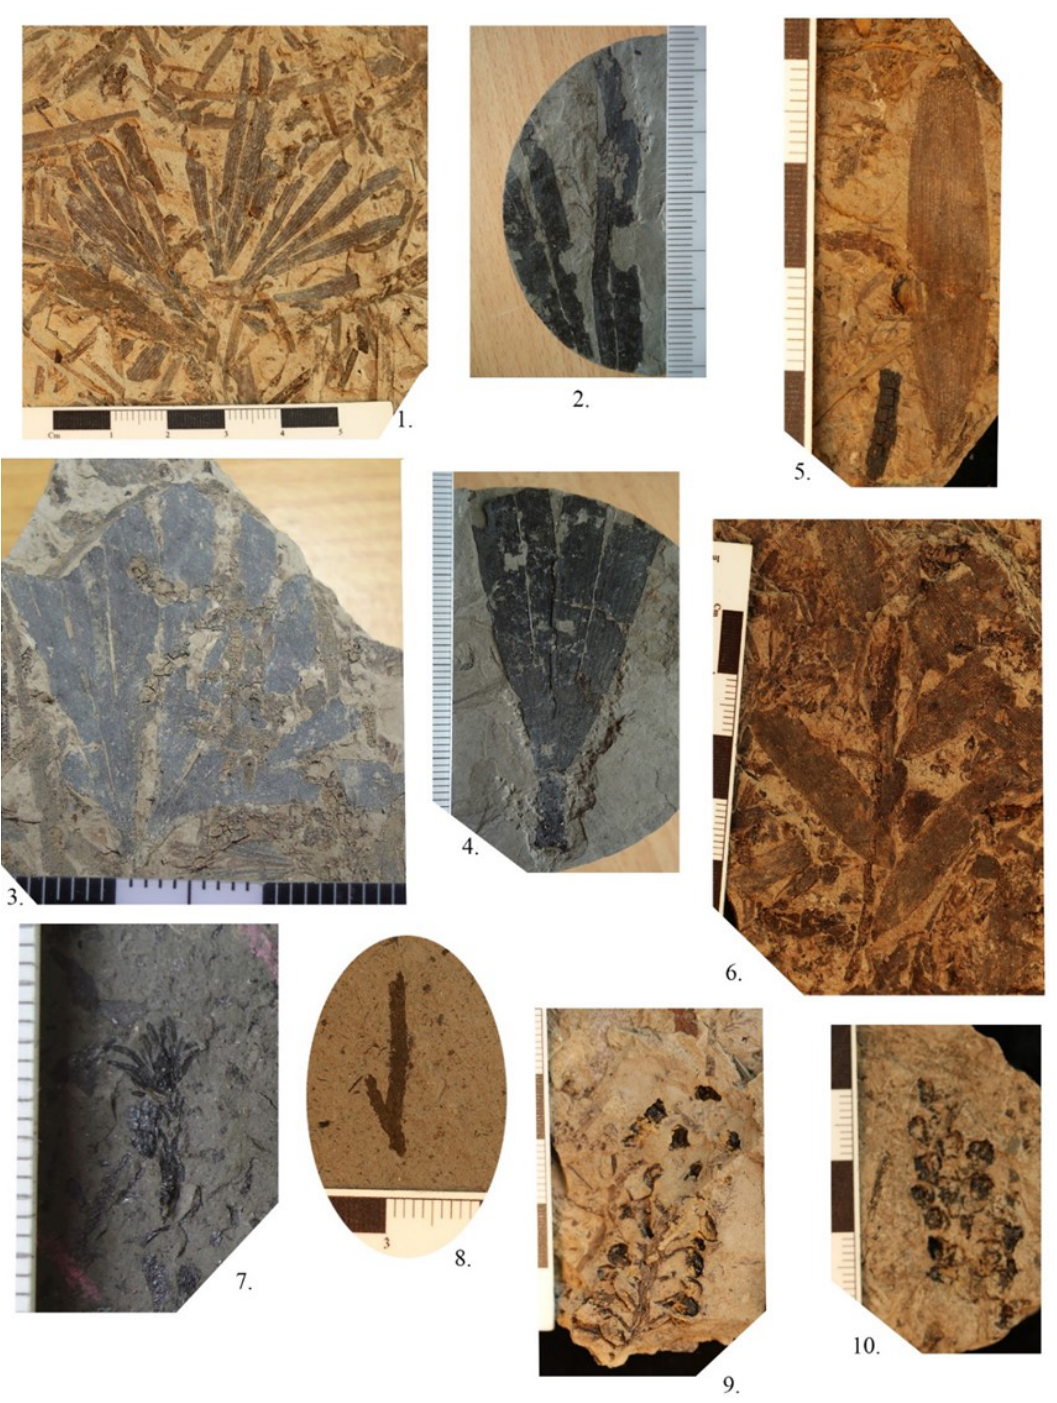
Plate I. Figs 1-10: 1- Acrostichopteris cf. vachrameevii E. Lebedev, Lower Cretaceous, Lower Albian; 2- Sphenobaiera cf. longifolia (Pomel) Florin, Lower Cretaceous, Barriaman-Aptian; 3 and 4: Sphenobaiera sp.; 5- Podozamites sp . ; 6- Podozamites cf. eichwaldii (?) Heer, Middle Jurassic-Lower Cretaceous, Barriaman; 7- Swedenborgia sp ., Lower Cretaceous; 8- Brachyphyllum sp ., Lower Cretaceous; 9 and 10: Ixostrobus sp ., Middle Jurassic-Lower